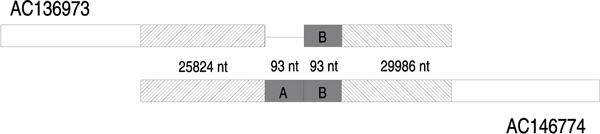
Window Alignment detects sequence contamination. The BAC AC146774 is possibly contaminated by an approximate copy A (93 nt) of a low complexity subsequence section B. Removing A from AC146774 yields a perfect alignment with one mismatch.